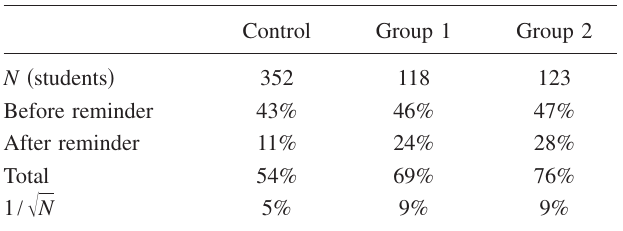
TABLE II. Compliance rates with email reminders. Before the first email reminder, the compliance rates were essentially identical. A greater percentage of those receiving email reminders completed the assessment than those who did